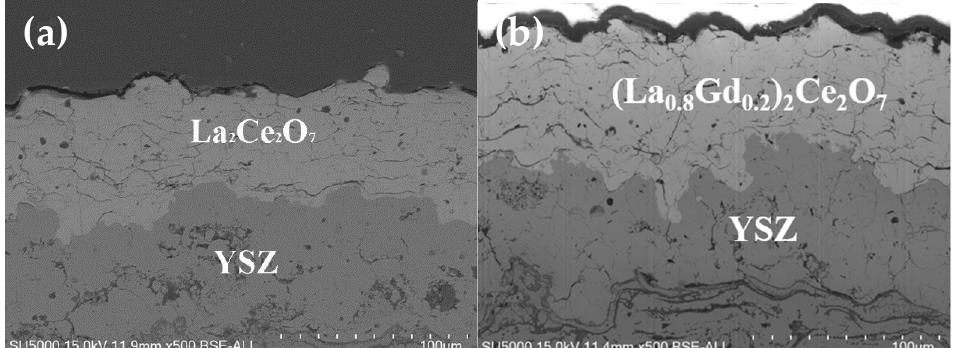
Figure 10. Cross-section micrographs of as-sprayed DCL TBCs: ( a ) La 2 Ce 2 O 7 /YSZ (LC/YSZ), and ( b ) (La 0.8 Gd 0.2 ) 2 Ce 2 O 7 /YSZ (LGC/YSZ).